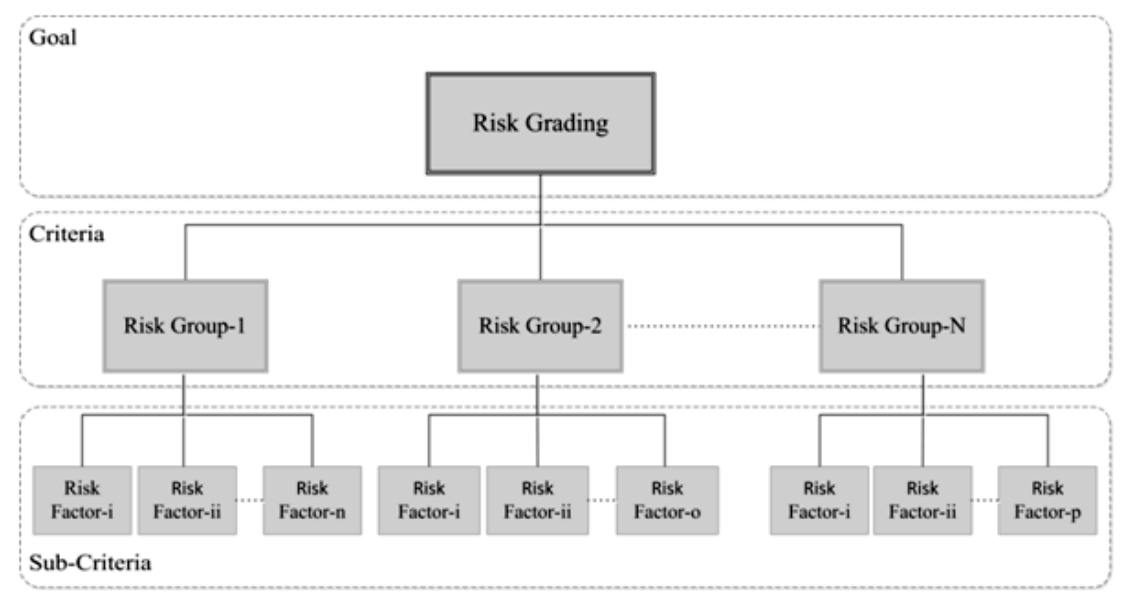
Figure 6. Representation of Multi Level